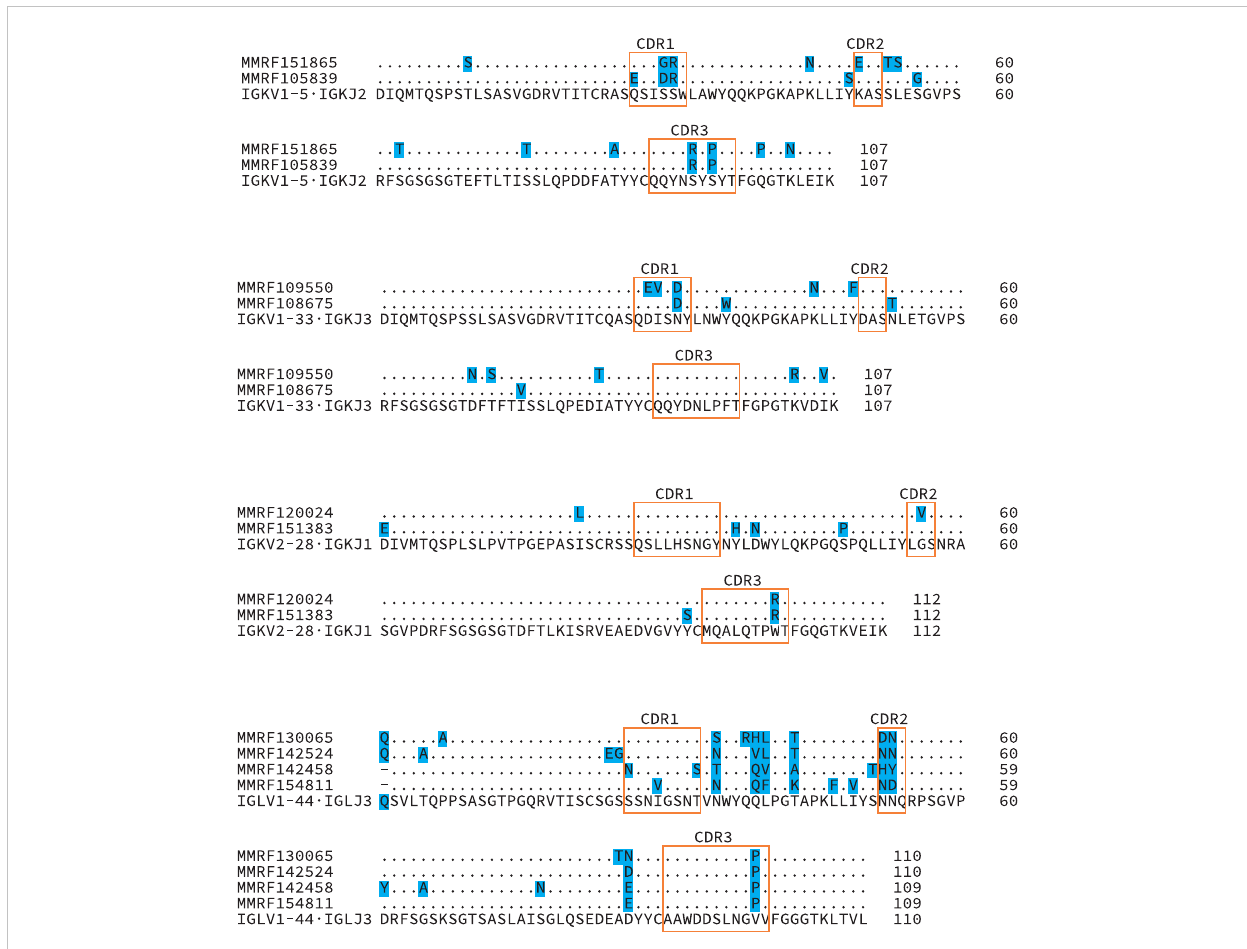
FIGURE 7 Diverse IGV L -IGJ L sequences despite identical CDR3 regions. Protein sequence alignments of four groups of clonal sequences where the CDR3 sequence is identical between clones. The IGV L and IGJ L genes identi fi ed for all sequences within each group were identical, and the inferred protein sequences for these germline precursors are shown beneath the clonal sequences. Shaded residues highlight differences between sequences. Orange boxes indicate CDR regions, according to the IMGT classi fi cation. Numbers represent local position within the